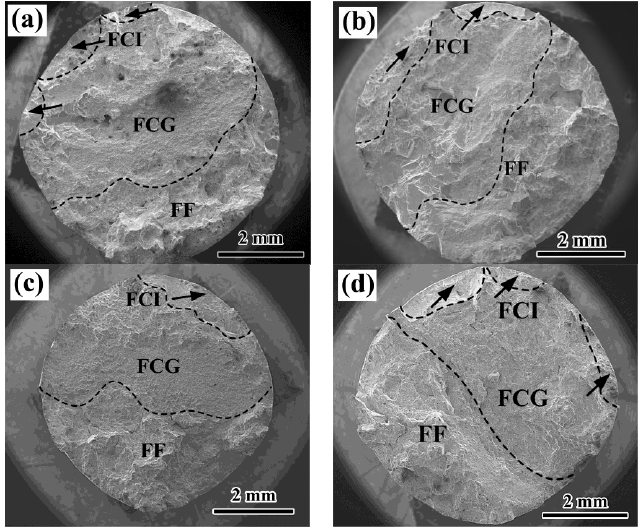
Figure 10. Scanning electron microscope (SEM) images of overall fracture surfaces of the alloy: NA alloy fatigued at the total strain amplitude of: ( a ) 1.2%; and ( c ) 1.8%. DA alloy fatigued at the total strain amplitude of: ( b ) 1.2%; and ( d ) 1.8%.